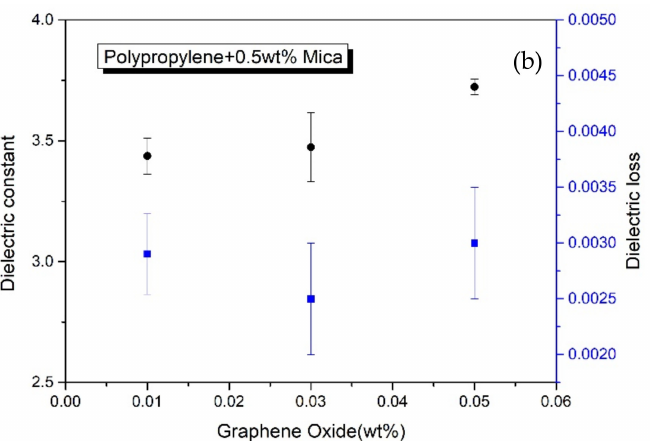
Figure 8. ( a ) the relative dielectric constant of PP film with different proportions of mica addition, ( b ) shows the relative dielectric constant and dielectric loss of 0.5 wt% mica with varying proportions of graphene oxide added to the PP